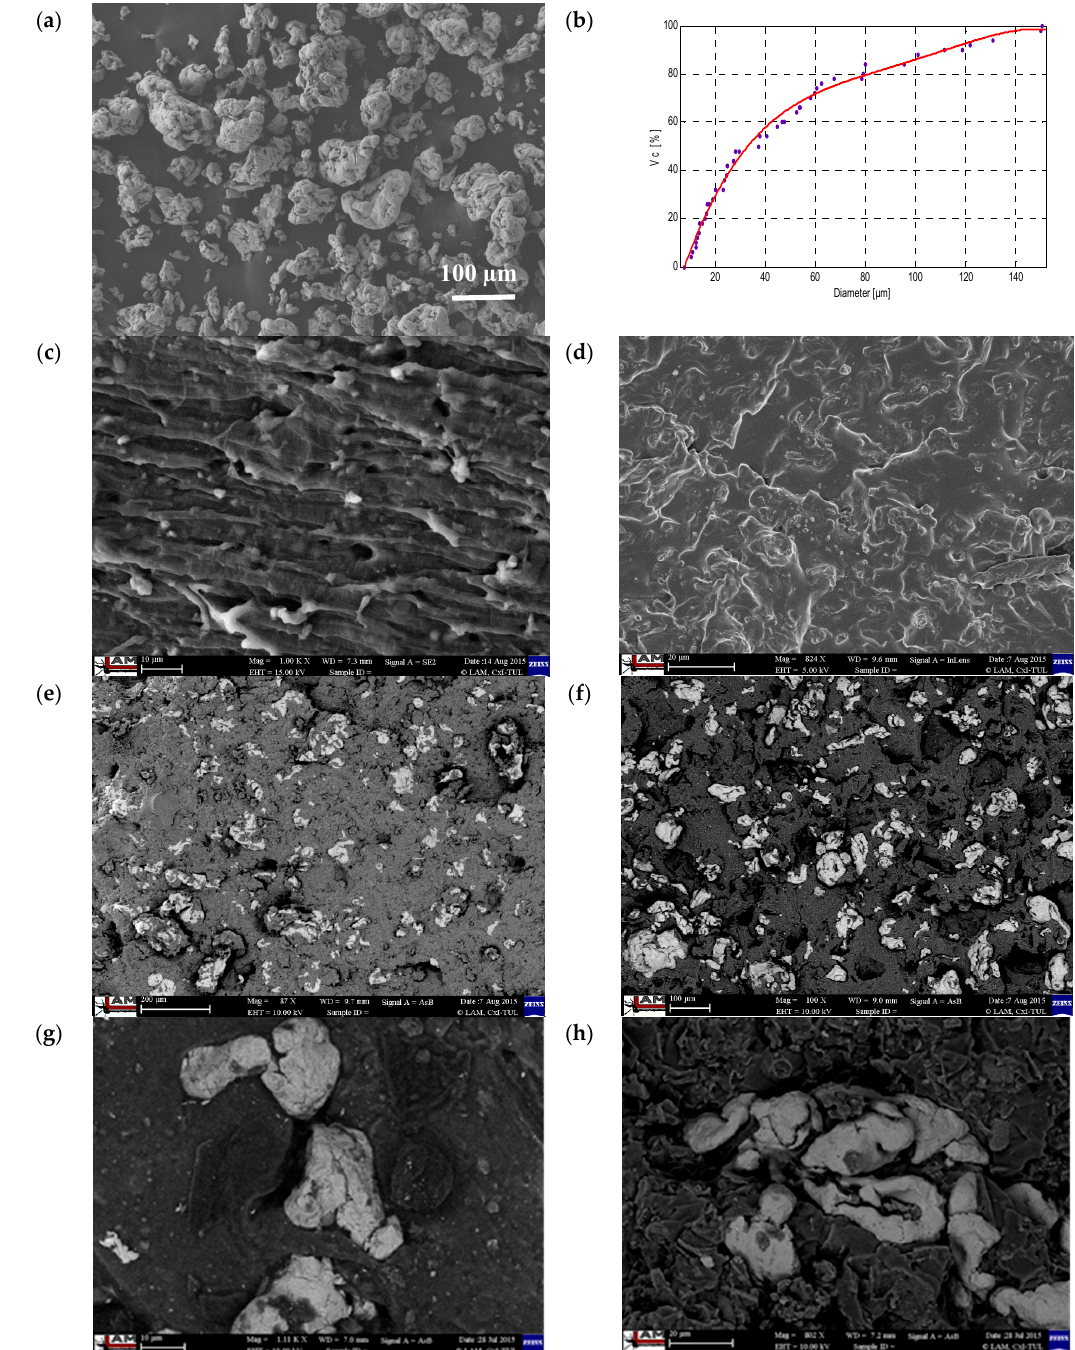
Figure 11. Filler, Elastomer, and MREs composite SEM images: ( a ) iron fillers, ( b ) particle size distribution in N1522 MRE composite, ( c ) Elastomer ZA22, ( d ) Elastomer N1522, ( e ) ZA22 Elastomer Composite, ( f ) N1522 Elastomer Composite, ( g ) Micro fibrils of ZA22 MRE composite, and ( h ) Micro fibrils for N1522 MRE composite. Reprinted from [18], © 2018 with permission from MDPI and from [21], © 2017 with permission from Wiley.